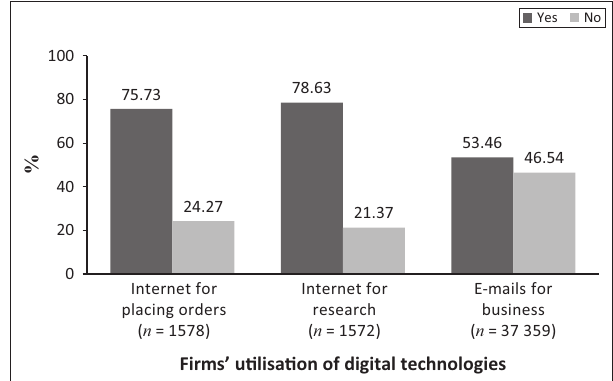
FIGURE 1: Gender composition of firms’ ownership and management.